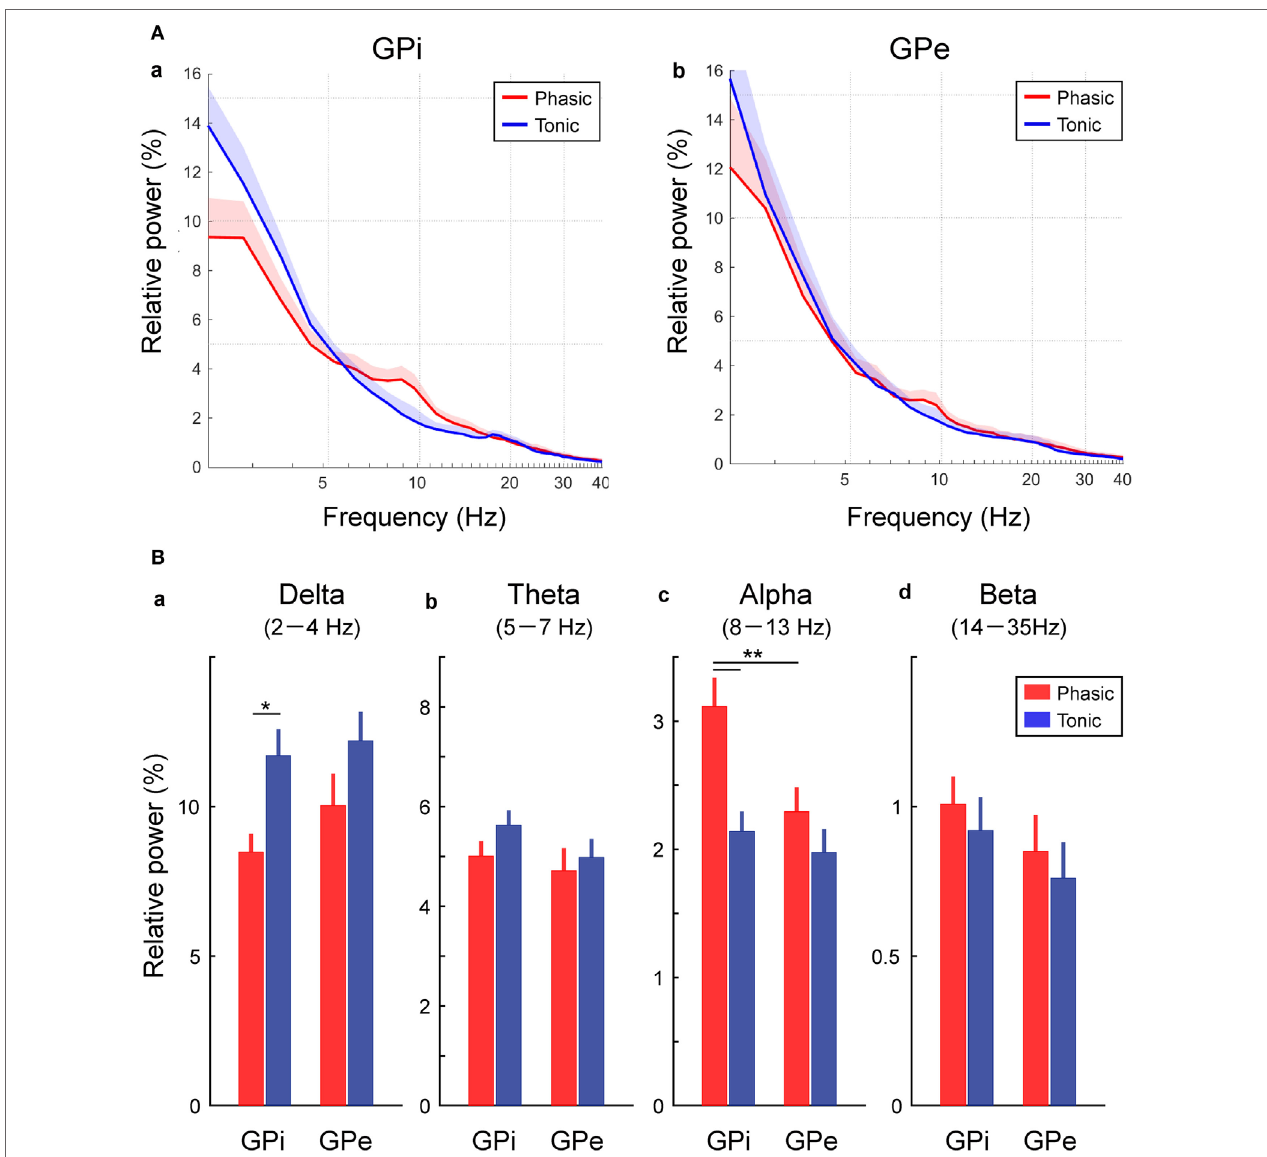
FigUre 2 | Frequency-specific GPi and GPe oscillatory activities in phasic and tonic patients. (a) The averaged relative power in the GPi (a) and GPe (b) over the delta (2–4 Hz), theta (5–7 Hz), alpha (8–13 Hz), and beta (14–35 Hz) frequency ranges in the x axis (log scale). Red and blue lines represent the averaged power spectrum in the phasic and tonic patients, respectively. The shaded area represents the area of SE. (B) Red and blue bars represent the relative power in GPi and GPe averaged over the delta (a), theta (b), alpha (c), and beta (d) frequency ranges in the phasic and tonic patients. The asterisks indicate a significant difference in GPi and GPe relative power (* p < 0.05 and ** p < 0.01). Error bars represent